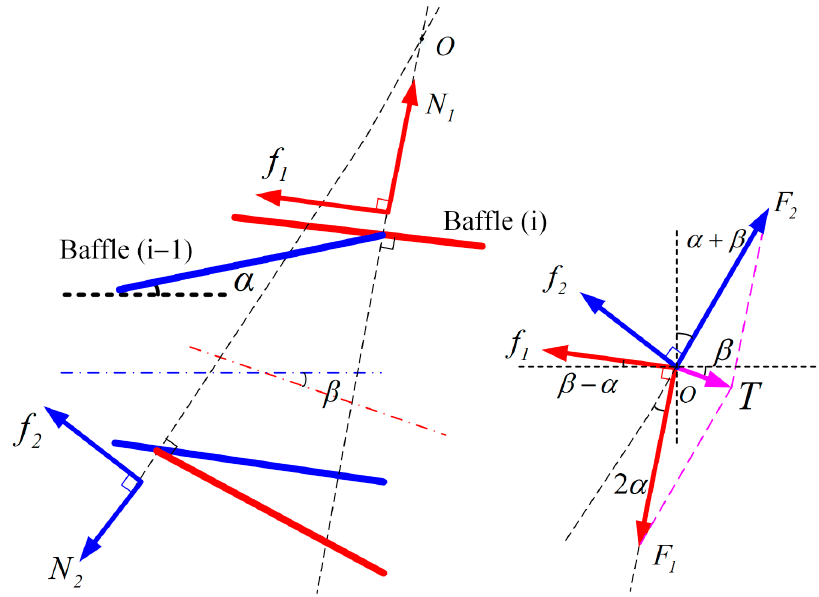
Figure 9. The stress model of the sub baffles and force analysis for deployable